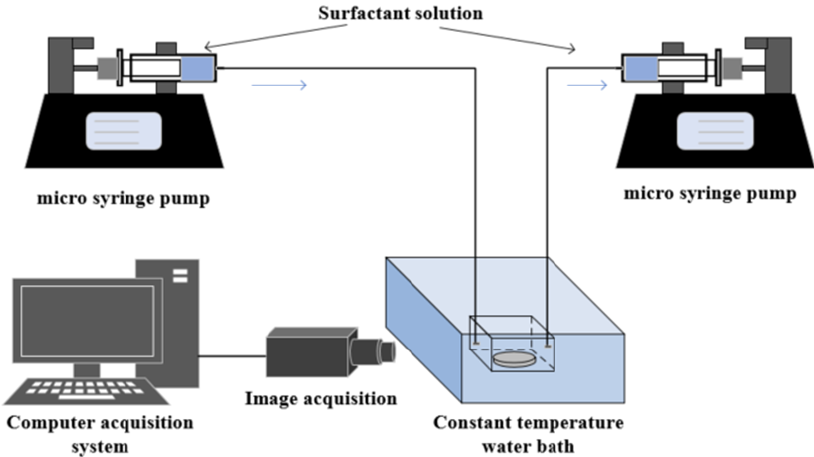
Figure 1. Oil drop visualization instrument for dynamic imbibition.